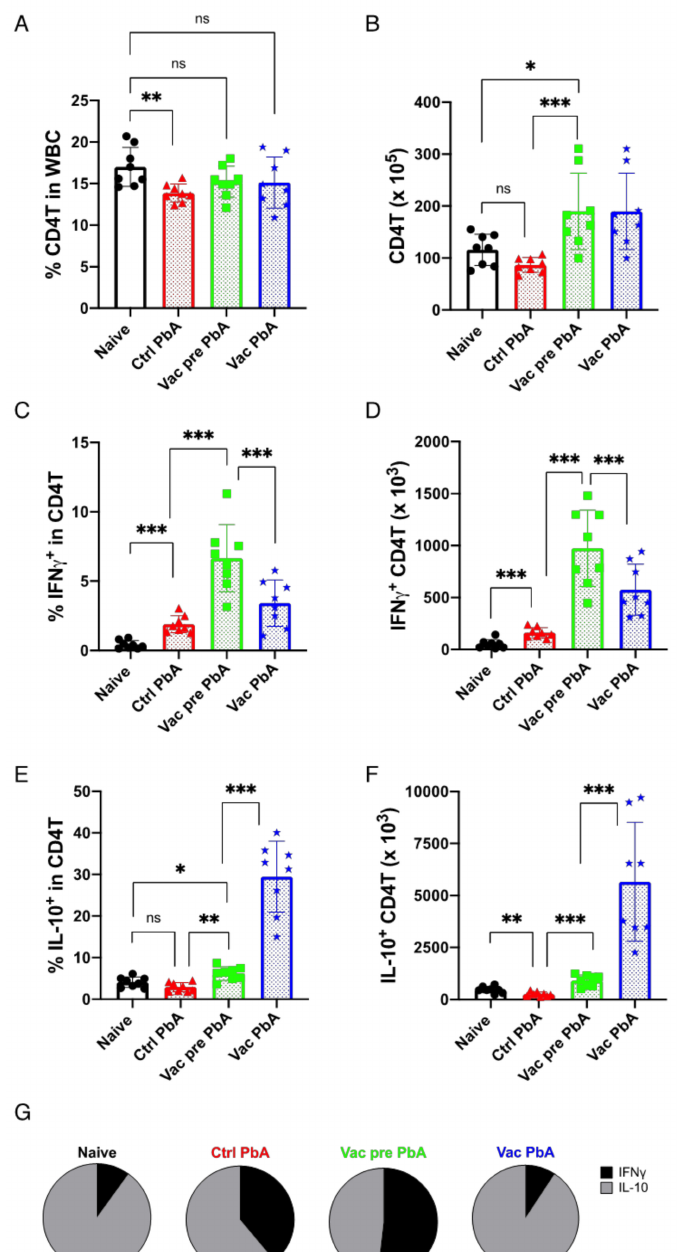
Figure 6. Plasmodium yoelii 17XNL live vaccination (Vac) tuned the balance between the pro- and anti-inflammatory response in splenic CD4 + T cells against P. berghei ANKA (PbA) challenge infection. Splenocytes from naive mice (N = 8; black circle), control (Ctrl) PbA mice infected on day 8 (N = 8; red triangle), Vac mice pre-infection and 40 days after vaccination with Plasmodium yoelii 17XNL (N = 8; green square), and Vac mice infected with PbA on day 8 (N = 8; blue star) were obtained to analyze intra-cellular cytokine production. ( A ) Proportion of CD4 + CD3 + (CD4T) cells in WBCs. ( B ) Absolute number of CD4T cells in the spleen. ( C ) Proportion of IFN γ producing cells in CD4T cells. ( D ) Absolute number of IFN γ -producing CD4T cells in the spleen. ( E ) Proportion of IL-10- producing cells in CD4T cells. ( F ) Absolute number of IL-10 producing CD4T cells. ( G ) Ratio of IFN γ -producing CD4T cells (black) to IL-10-producing CD4T cells (gray). Data are pooled from 2 independent experiments. * p < 0.5; ** p < 0.01; *** p < 0.001; ns: not significant. Each symbol represents one mouse. Data represent the mean ± standard deviation (SD). p values were determined by two-tailed Student’s t